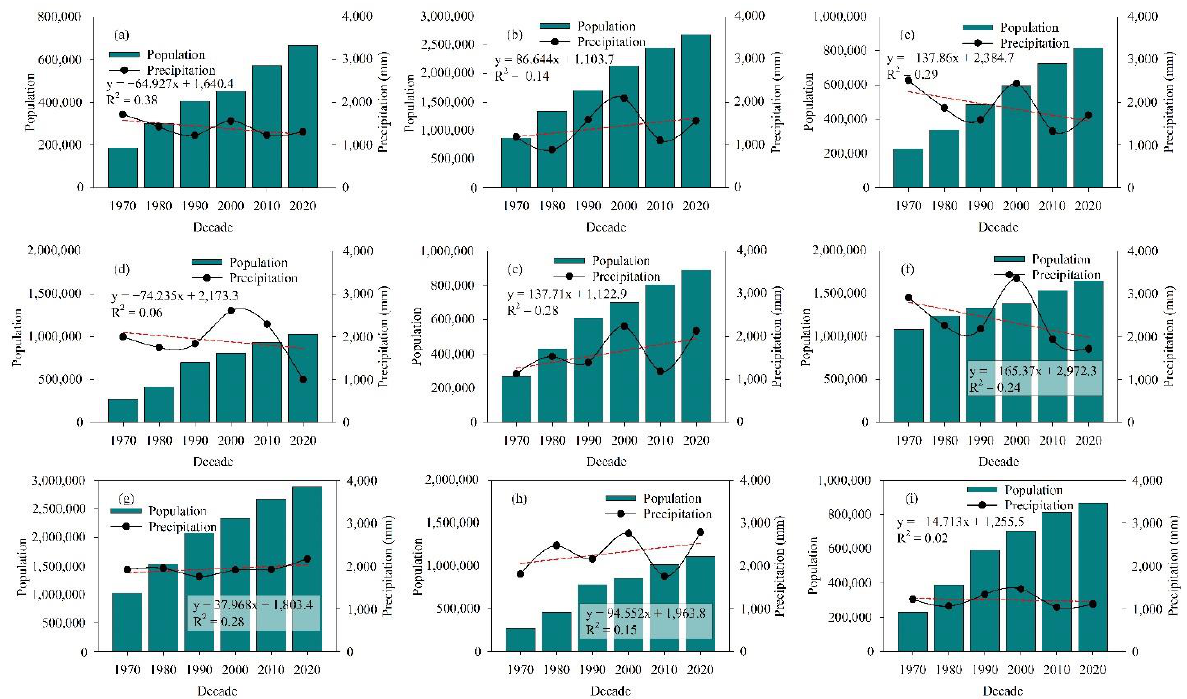
Figure 9. Relational pattern between average rainfall (mm) by decade and population (inhabitants) in the capitals of the NEB: Aracaju ( a ), Fortaleza ( b ), João Pessoa ( c ), Maceió ( d ), Natal ( e ), Recife ( f ), Salvador ( g ), São Luís ( h ), and Teresina ( i ).